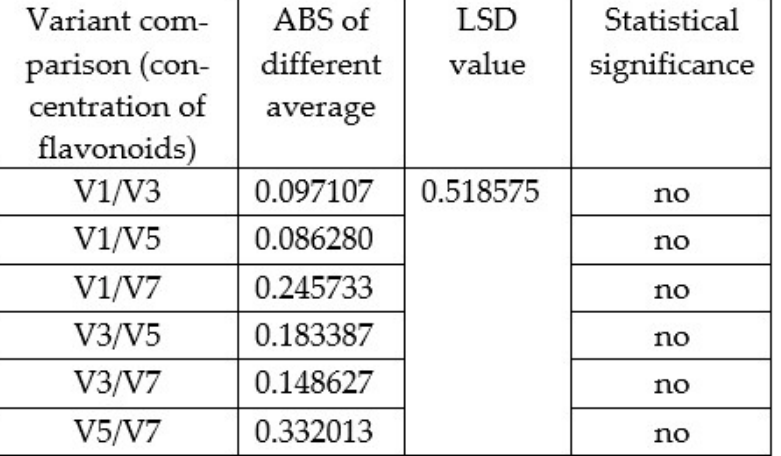
Figure 11. The statistical significance determined by LSD (Least Significant Difference) test values of antioxidant activity in Lepidium sativum L. sprouts cultivated on gauze (V1 control, illuminated with sunlight; V3, illuminated with white LED; V5, illuminated with blue LED; and V7, illuminated with red LED experimental variant), t crit value = 2.306004.